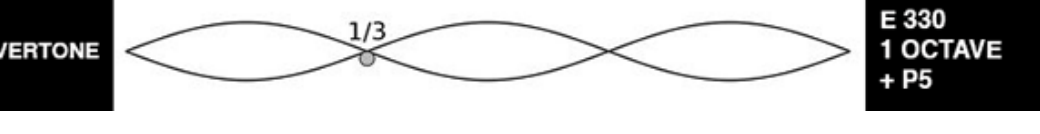
Figure 3. The Second Overtone.